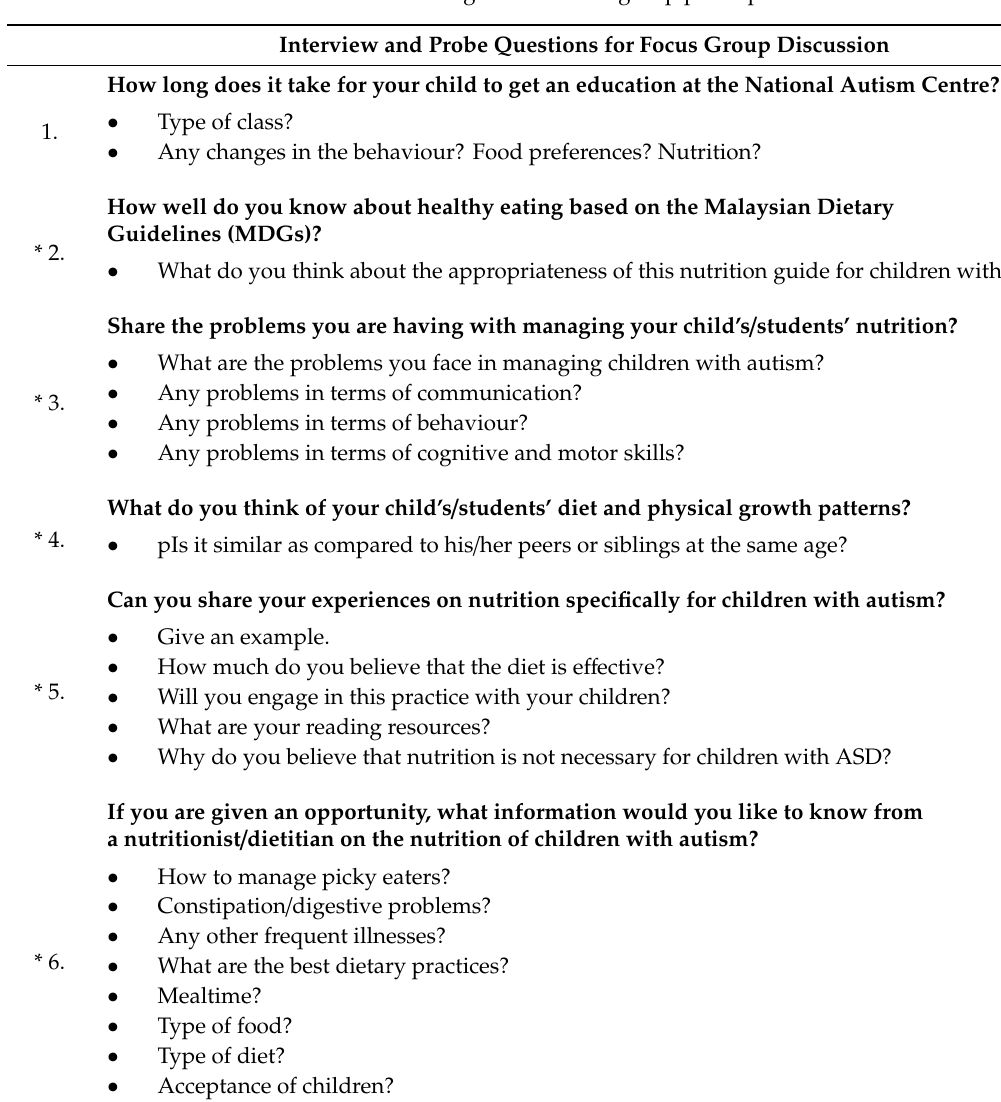
Table 1. Interview guide for focus group